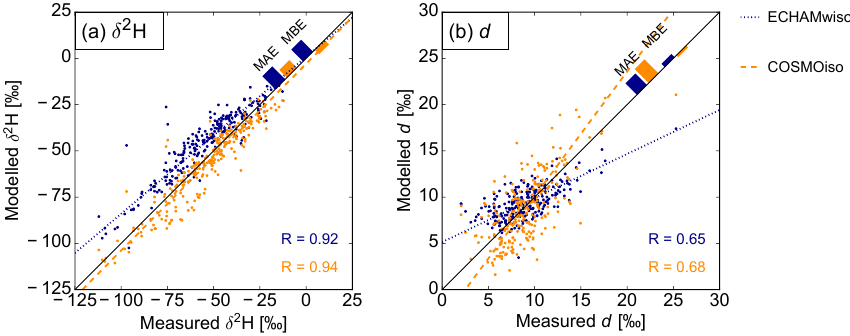
Figure 3. Seasonal mean values of (a) δ 2 H and (b) d in precipitation from ECHAMwiso (dark blue) and COSMOiso (orange) with respect to the GNIP measurements. Each dot represents the value at one GNIP station averaged over one season and 30 years. The lines are orthogonal regression lines (Adcock, 1878). MAE, MBE, and R are the mean absolute error, the mean bias error, and the linear correlation coefficient,